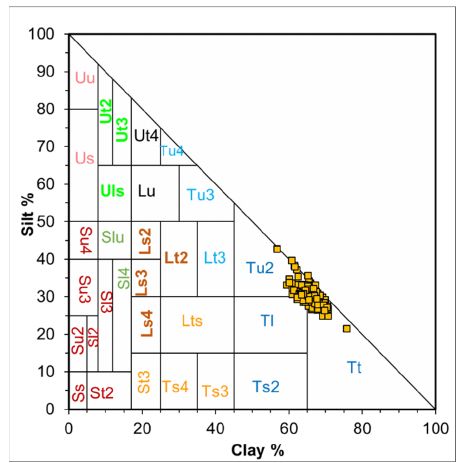
Figure 3. The particle size distribution of the whole soil profile Pulling 8.